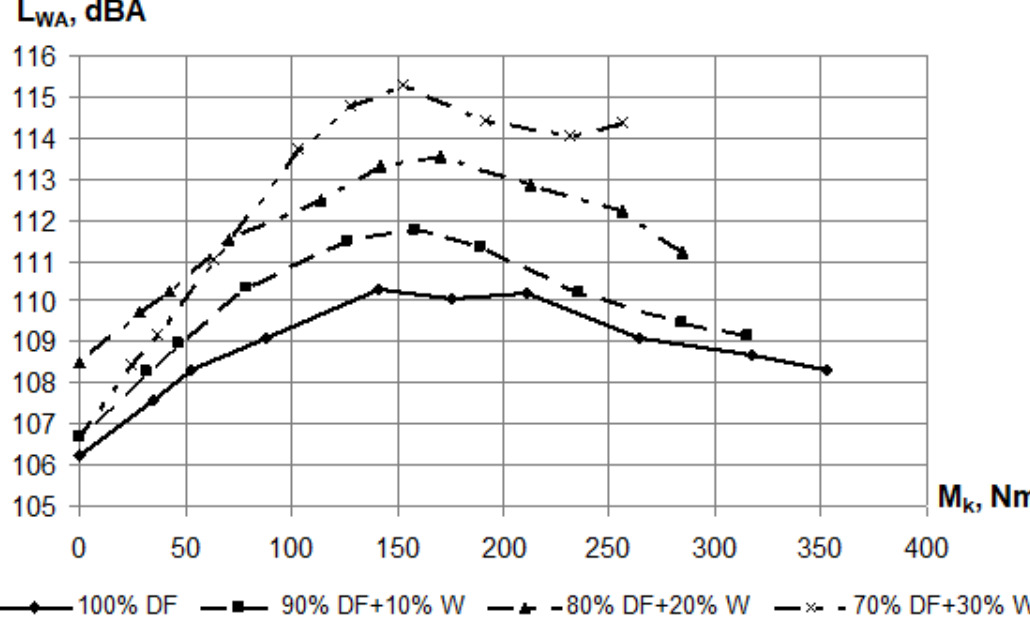
Figure 9. Overall noise levels of engine when working on diesel fuel and water–fuel emulsions at n = 1700 rpm.